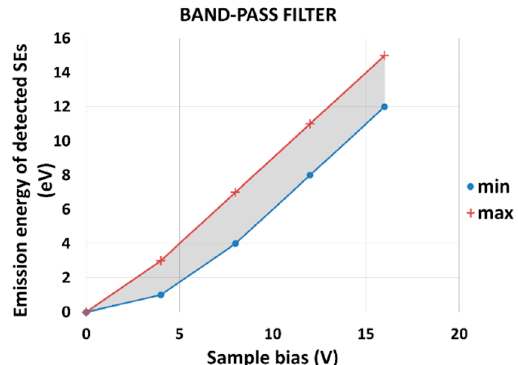
Figure 5. The final general graph for the band-pass filter. Emission energy of detected SEs as a function of the sample bias; E P = 1 keV, WD = 1 mm.